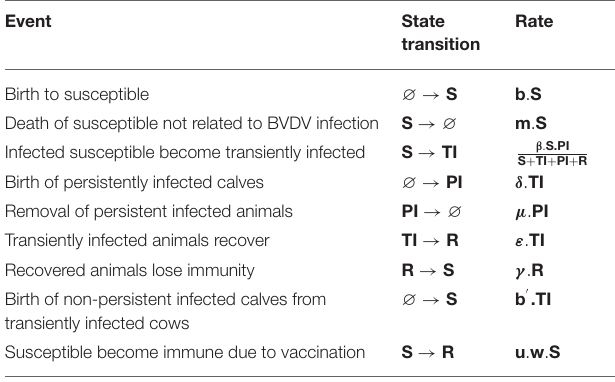
TABLE 1 | Transitions in the within-herd model.